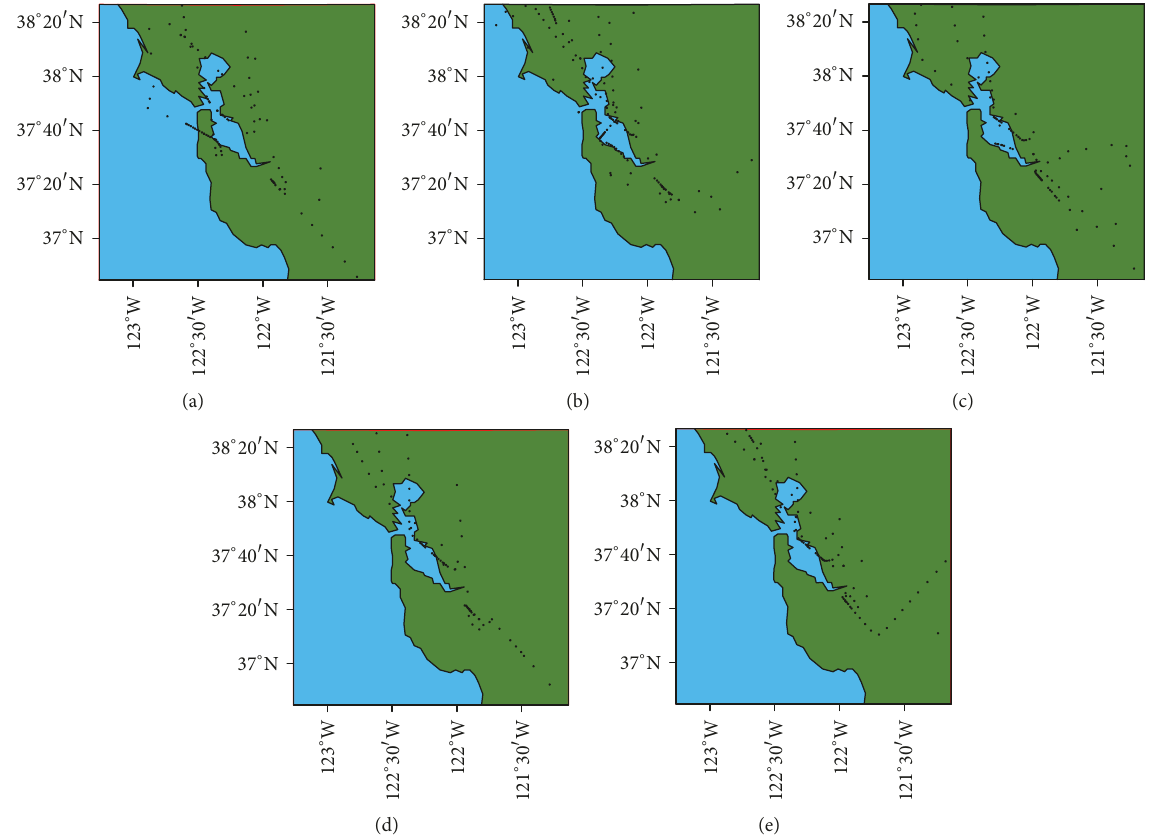
Figure 2: Horizontal distribution of TAMDAR observations over the 1km WRF-ARW domain during the assimilation period (12–18 UTC) for the following dates in 2012: (a) 7 February, (b) 9 February, (c) 16 February, (d) 1 March, and (e) 5